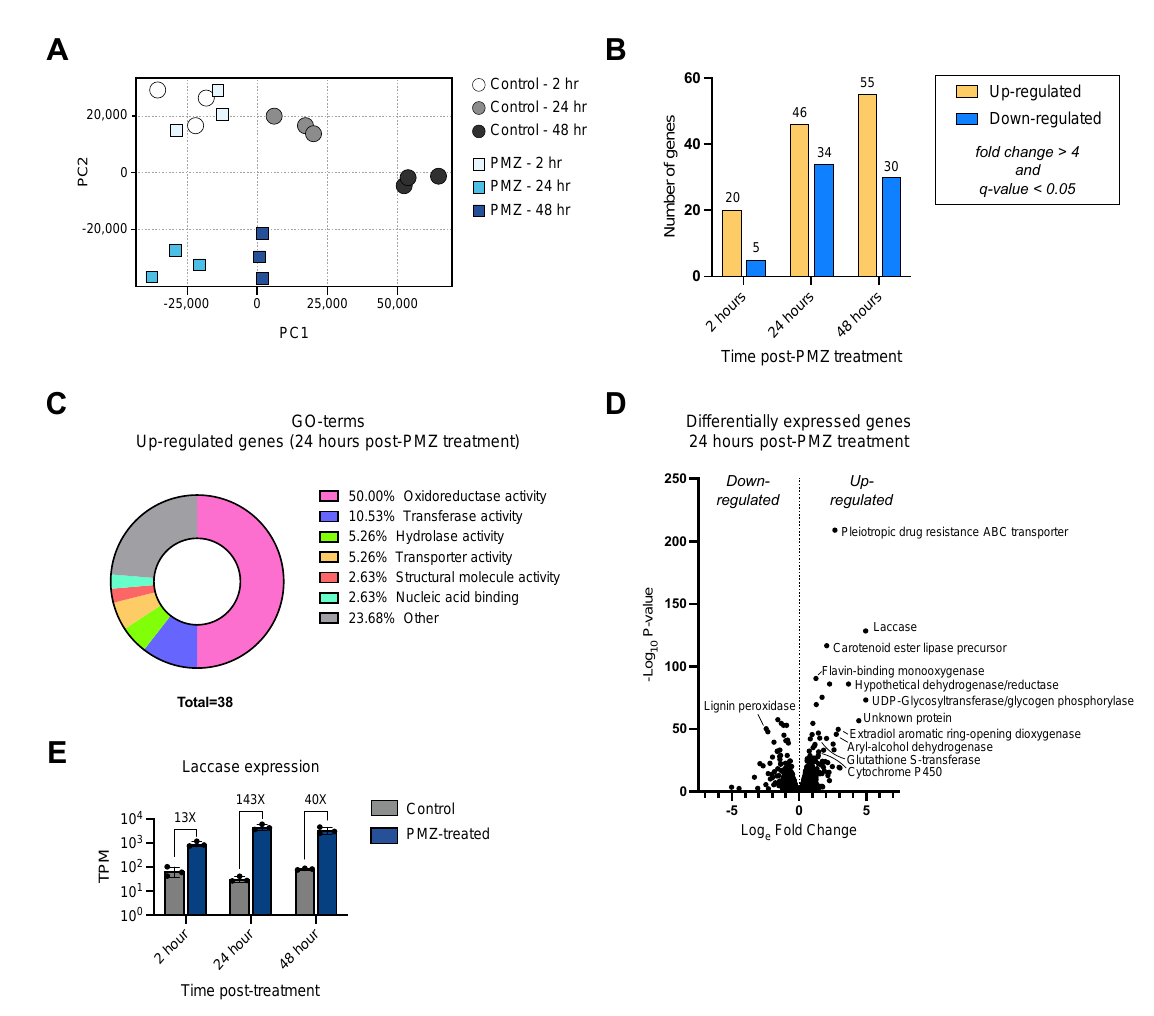
Figure 4. Transcriptomic analyses of P. radiata in response to promethazine treatment. ( A ) PCA plot depicting RNA-seq transcriptional profiles of untreated control and promethazine-treated P. radiata at different time points. ( B ) Bar chart of the number of significant differentially expressed genes at time points post treatment. Genes included here were filtered for a q-value < 0.05 and a fold change > 2. ( C ) Donut plot showing the breakdown of molecular function GO terms identified among the significantly upregulated genes 24 h after promethazine treatment. ( D ) Volcano plot highlighting a selection of the most upregulated genes in P. radiata 24 h after promethazine treatment. ( E ) Laccase gene expression levels measured at 2 h, 24 h, and 48 h post promethazine treatment depicted in transcripts per million (TPM). Bars represent the mean of three biological replicates with individual data points shown, and error bars depict the standard